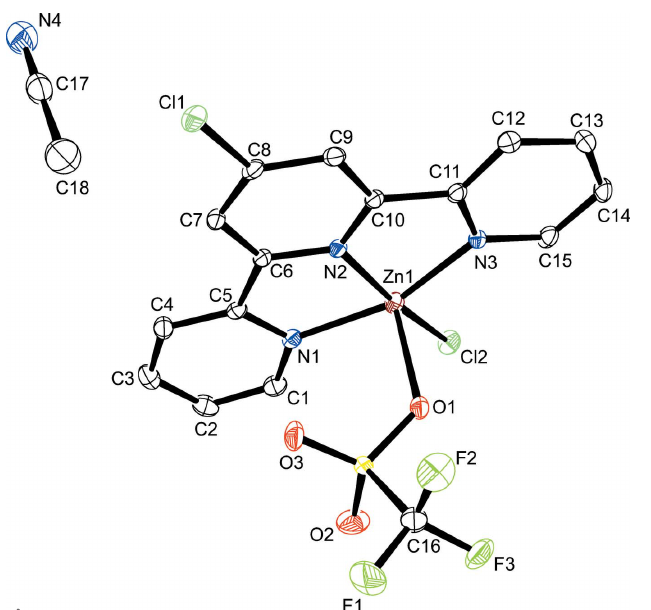
Figure 1 The molecular structure of the title compound with displacement ellipsoids drawn at the 50% probability level; H atoms are omitted for clarity.